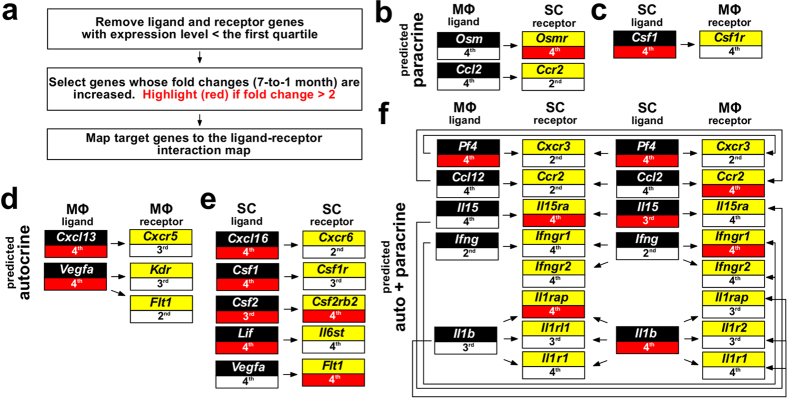
Potential paracrine and autocrine regulations in 7-month-old neurofibroma microenvironment.The relative expression levels are represented as quartiles (1st: lowest, 4th: highest). DEGs compared to 1-month-old neurofibroma SCs (Nf1−/−) and neurofibroma macrophages (Nf1+/+) are indicated in red boxes (fold >2).